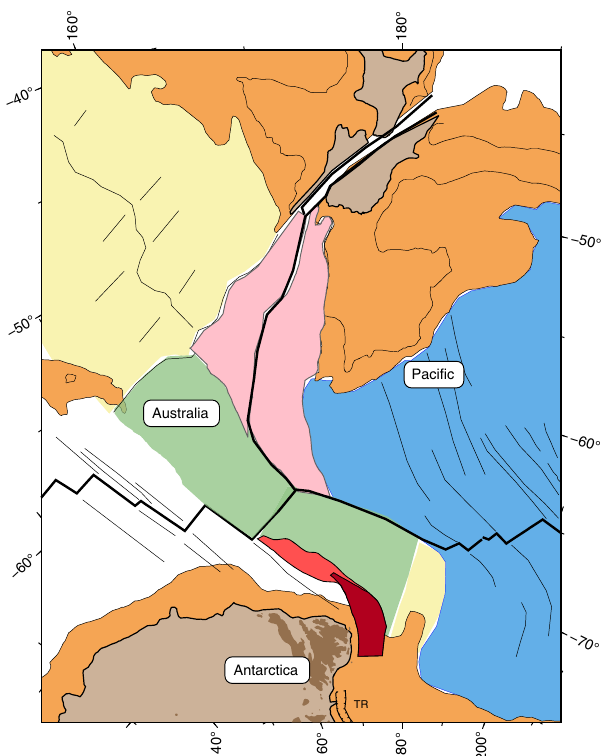
Fig. 3 Plate reconstruction for the time of anomaly 5o, shortly after the fi nal cessation of East-West Antarctic plate motion. Antarctica is fi xed. The more recent displacement caused by the formation of the Macquarie microplate is restored using the Macquarie-Australia rotation parameters (Table 1). Thick black lines delineate active plate boundaries. Colour shadings follow those in Fig. 1. TR, Terror